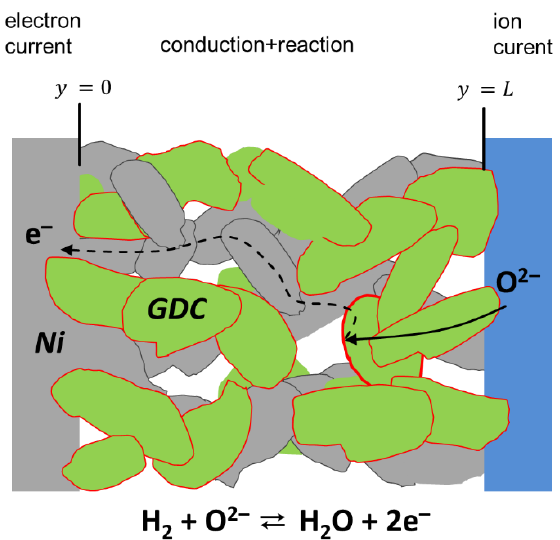
Figure 1. Sketch of conduction and surface reaction in a porous Ni / GDC (gadolinium-doped ceria) electrode, including ion and electron conduction, as well as electrochemical fuel oxidation on the GDC surface.